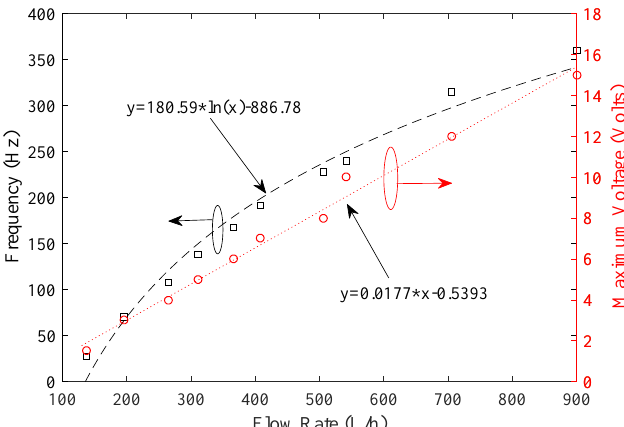
Figure 9. Voltage and frequency behavior of generated